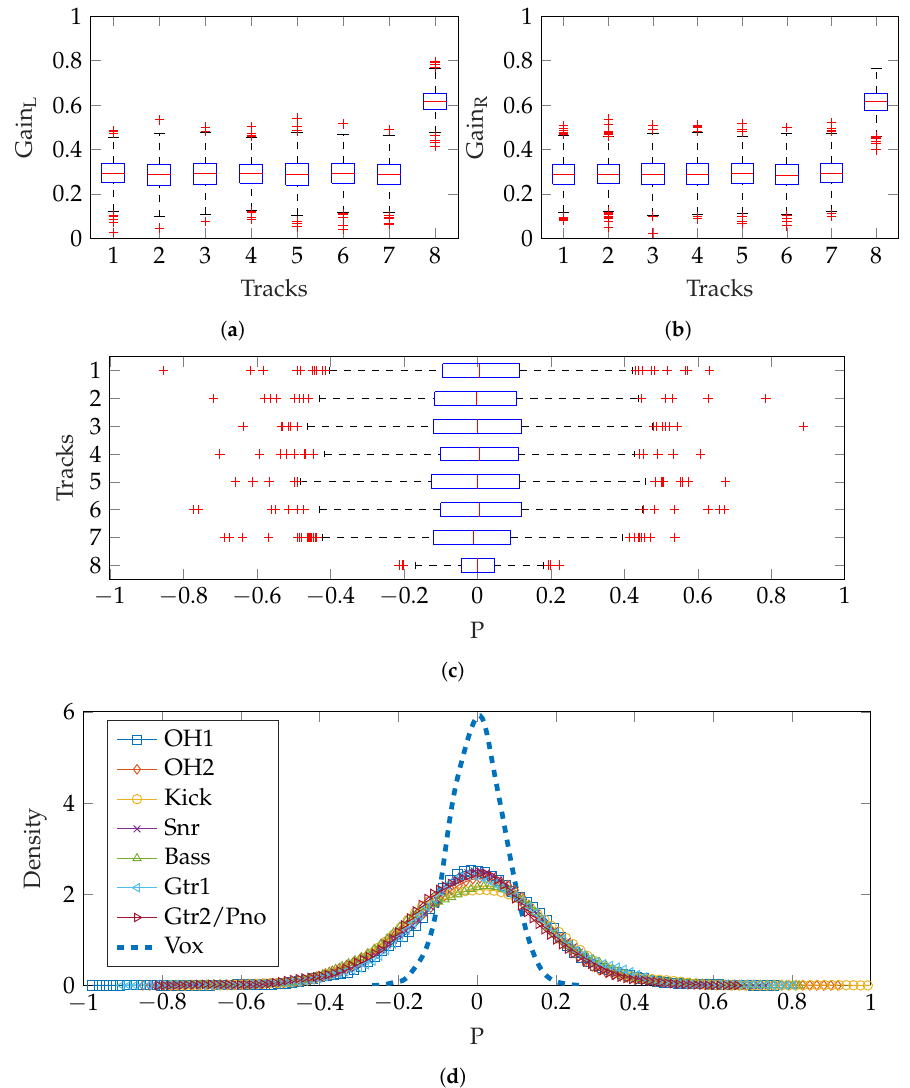
and gain , both using Equation (7). L R